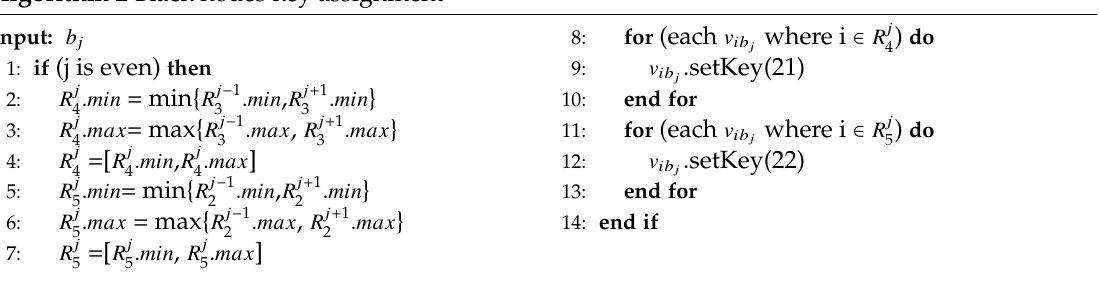
Algorithm 2 Black nodes key